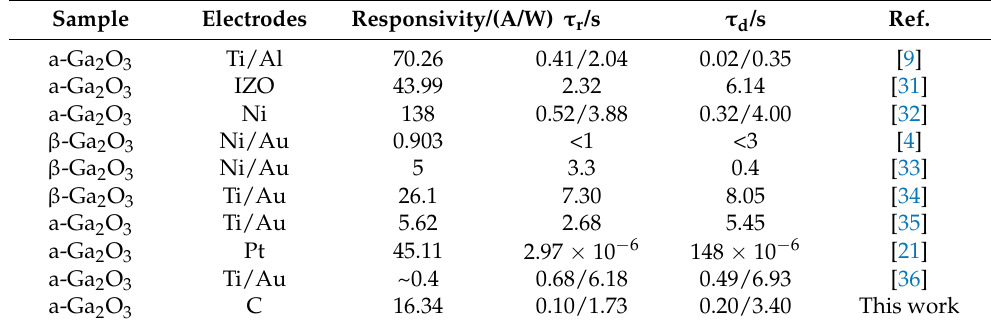
Table 1. Comparison of main performance indexes of gallium oxide-based MSM photodetectors with different electrodes at home and abroad.